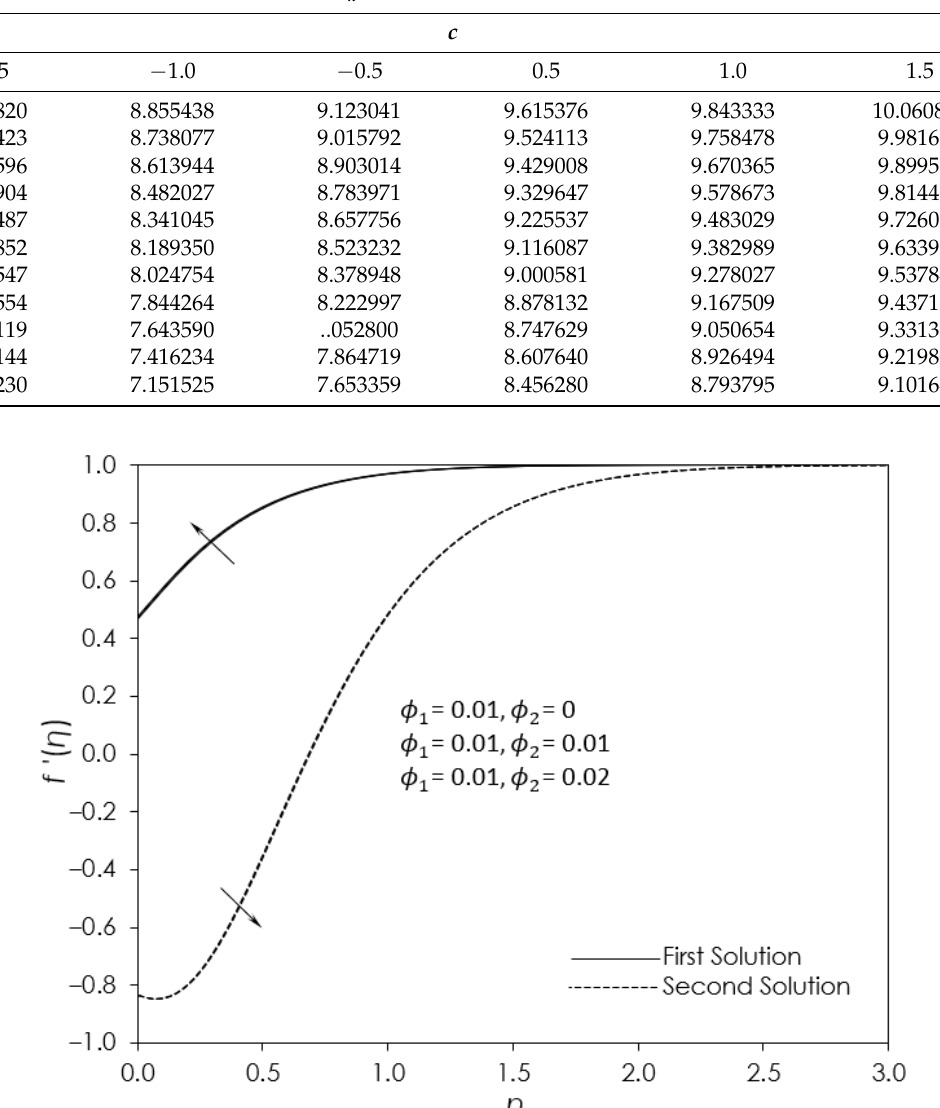
Figure 7. Variation of 𝑓′(𝜂) for different values of 𝜙 2 .